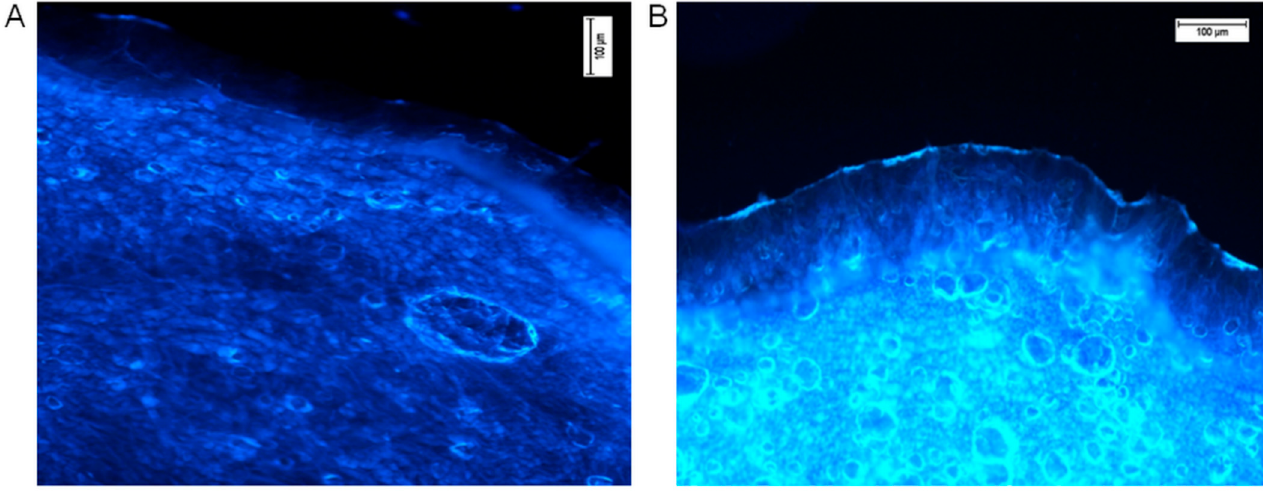
Figure 3. Hesperidin distribution in the human skin ( A —the control, ethanol 96% alone, B —ethanol hesperidin solution 96%, 0.01 mg/mL). Ethanol and hesperidin solutions were applied on the human skin ex vivo. After 24 h of incubation, skin was washed in water and analysed under a fluorescence microscope, Nikon Eclipse 50, filter UV 2A, Ex 330–380 nm.